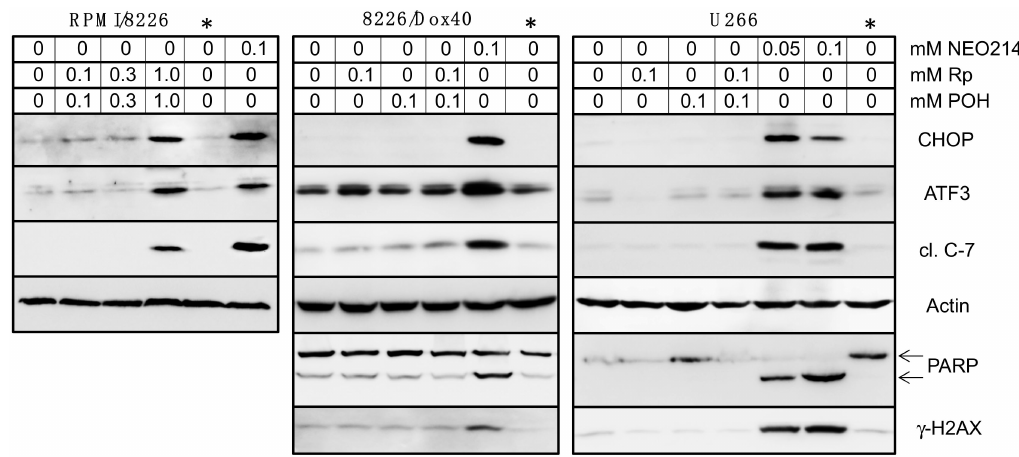
Figure 6. NEO214 is more potent than the sum of its parts. RPMI/8226, 8226/Dox40, and U266 cells were treated with Rp alone, POH alone, and Rp plus POH in combination, at the indicated concentrations. For comparison purposes, cells were also treated with NEO214 in parallel. Control cells remained untreated (left lane in each panel) or were treated with vehicle (lanes marked by asterisk: *). After 24 h, cell lysates were prepared and subjected to Western blot analysis with actin as the loading control. Note effective induction of stress markers (CHOP and ATF3) and apoptosis markers (cleaved/active caspase 7, PARP and γ -HA2X) by 0.05 and 0.1 mM NEO214, whereas Rp and POH, alone or in combination, did not affect expression of these markers, unless their concentrations were increased to 1 mM each (left panel). (Due to the high concentrations included, drug concentrations in this figure are shown in units of millimolar).